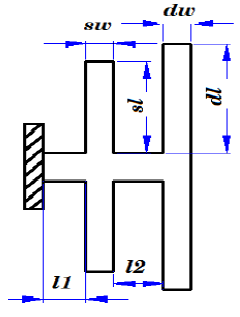
Figure 7. The dimensions of the